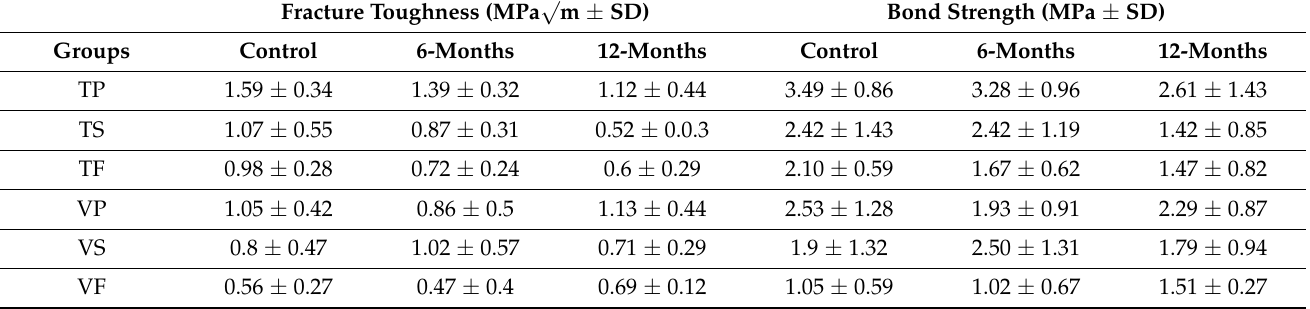
Table 2. Summary of fracture toughness (Mpa (Mpa ±